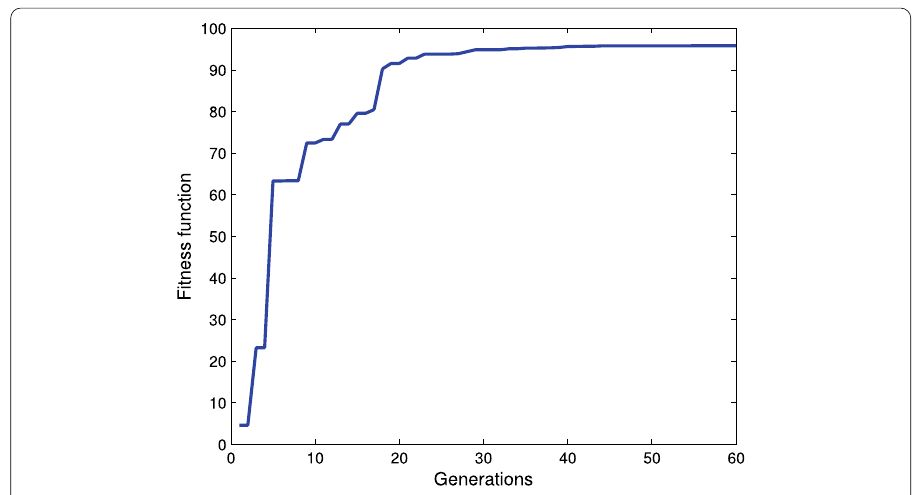
Fig. 8 The fitness function with generations for a single